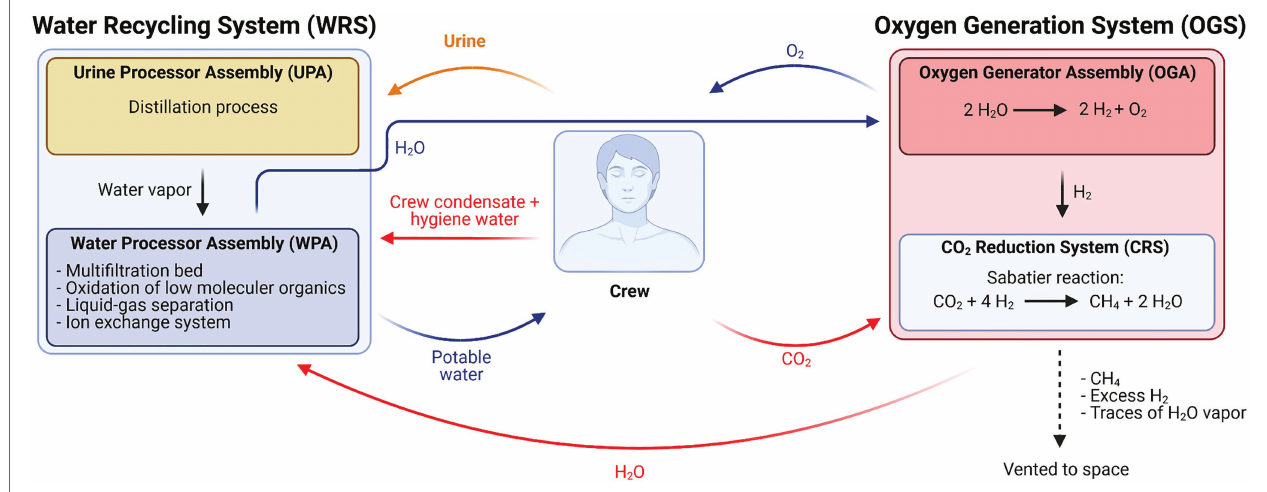
FIGURE 1 | Simplified schematic overview of the Environmental Control and Life Support System (ECLSS) currently in use on the International Space Station (ISS; Adapted from Volpin et al.,